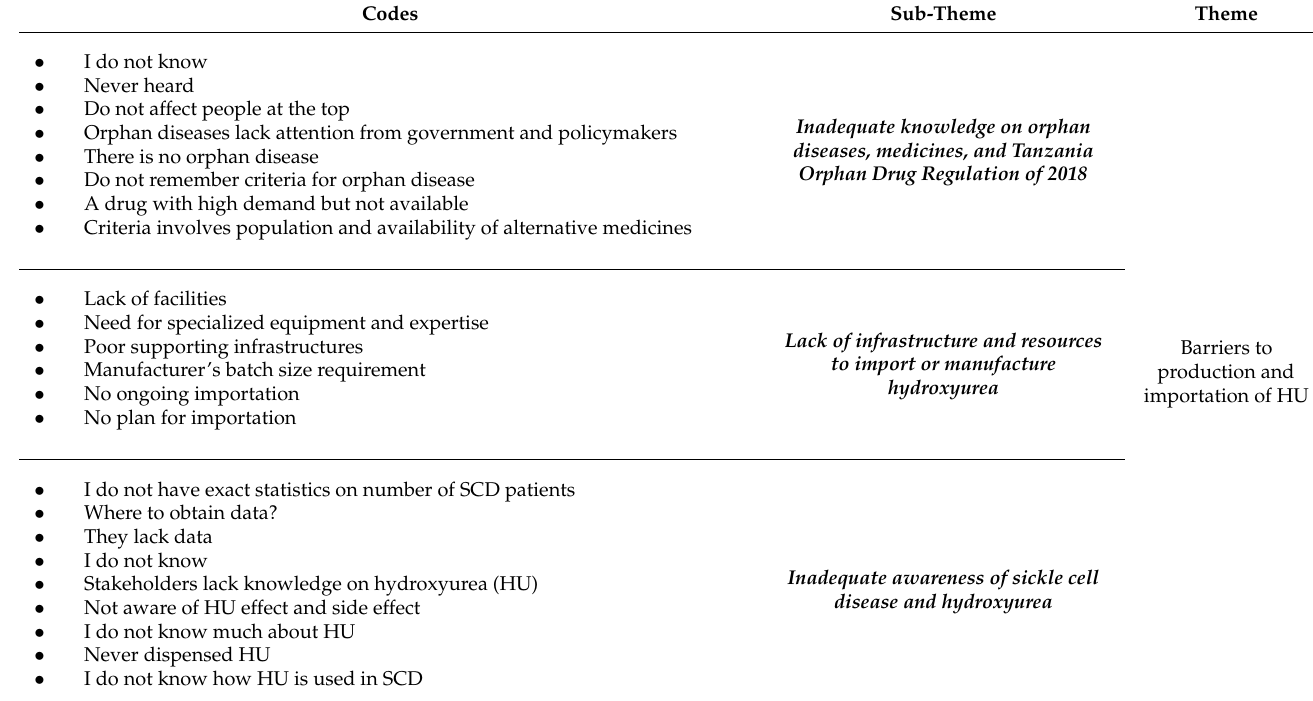
Table 2. Pattern of